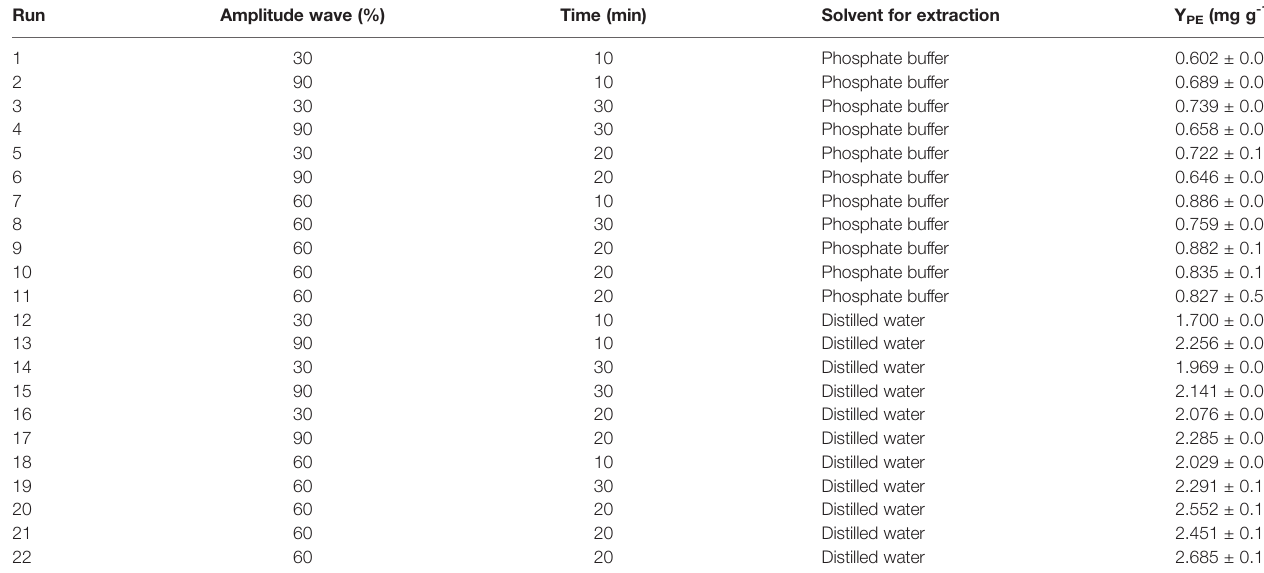
TABLE 1 | Central composite design for ultrasound-assisted method and yield (YPE) results from response surface method analysis. Run Amplitude wave